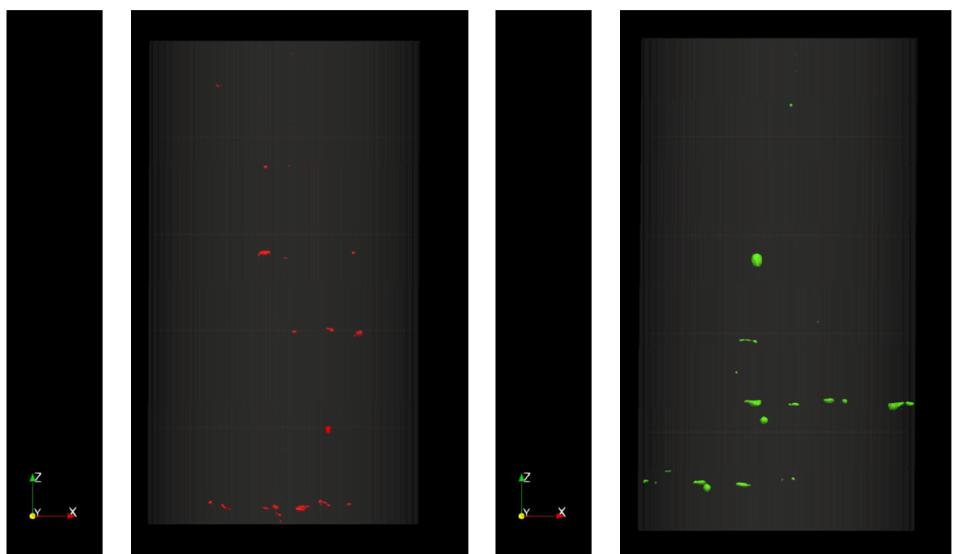
Figure 5. Micro-CT 3D reconstruction (18 µm/voxel) of specimen. Cylinder specimen dimensions: 20 mm × 10 mm (length × diameter), red volumes indicate manufacturing defects identified as porosity. X direction represents the longitudinal bead layering direction, Y represents the transverse bead direction.